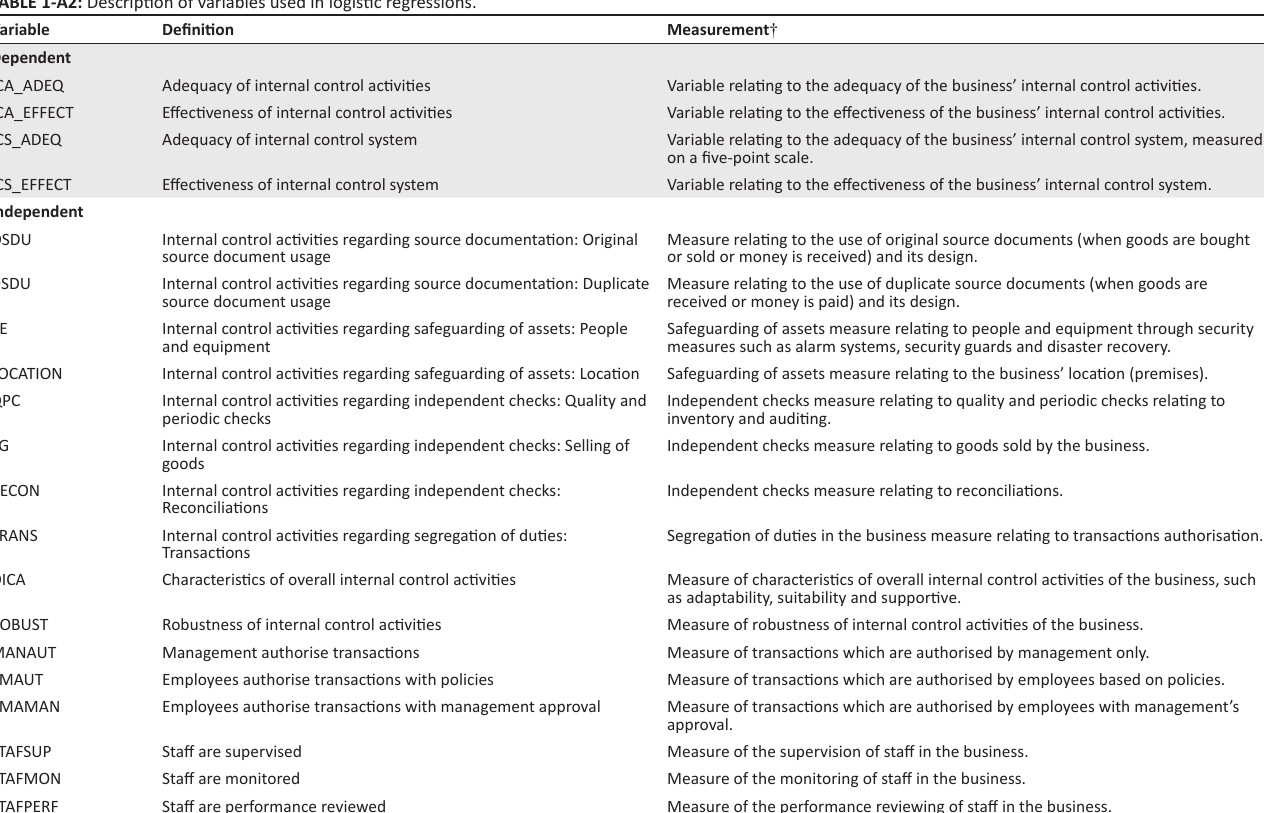
TABLE 1-A2: Description of variables used in logistic